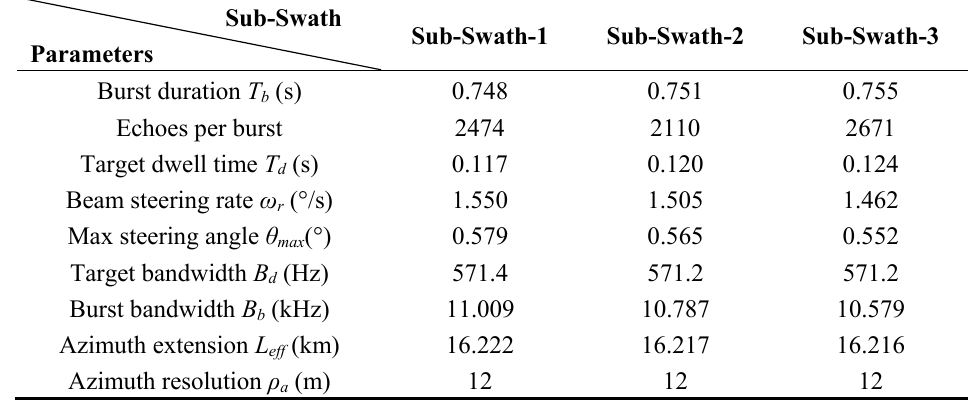
Table 3. Parameters of different sub-swaths in Terrain Observation by Progressive Scans (TOPS).